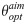
Simulations of Experiment 1.Reach angle (y-axis) over trials (x-axis) when using our learning model to simulate an ‘individual’ experiencing A) the steep reinforcement landscape and B) the shallow reinforcement landscape. In A) and B), during the experimental trials, the blue and orange circles respectively indicate that the model received reward on a given trial, while the black circles indicate no reward. At the individual level, the learning model does well to capture individual movement variability and a faster rate of learning when experiencing the steep reinforcement landscape (compare to Fig 3A and 3B). For A), B), and C) the grey vertical lines separate baseline trials (1-50), experimental trials (51-400) and washout trials (401-450). The dashed horizontal lines indicate the optimal intended reach aim (θoptaim) to maximize reward. C) Average reach angle (y-axis) over trials (x-axis) when using the learning model to simulate 40 ‘individuals’ for both the steep (blue) and shallow (orange) reinforcement landscape. Shaded regions represent ± 1.0 SE. The thick blue and orange curves represents the best-fit exponential functions to the average reach angles of simulated ‘individuals’ that experienced the steep or shallow reinforcement landscapes, respectively. For comparison, the inset displays the behavioural data of Experiment 1 (also shown in Fig 2C). At the group level, the learning model does well to capture between-subject variability, reproduces a faster rate of learning for the steep landscape, and gives rise to exponential learning curves.